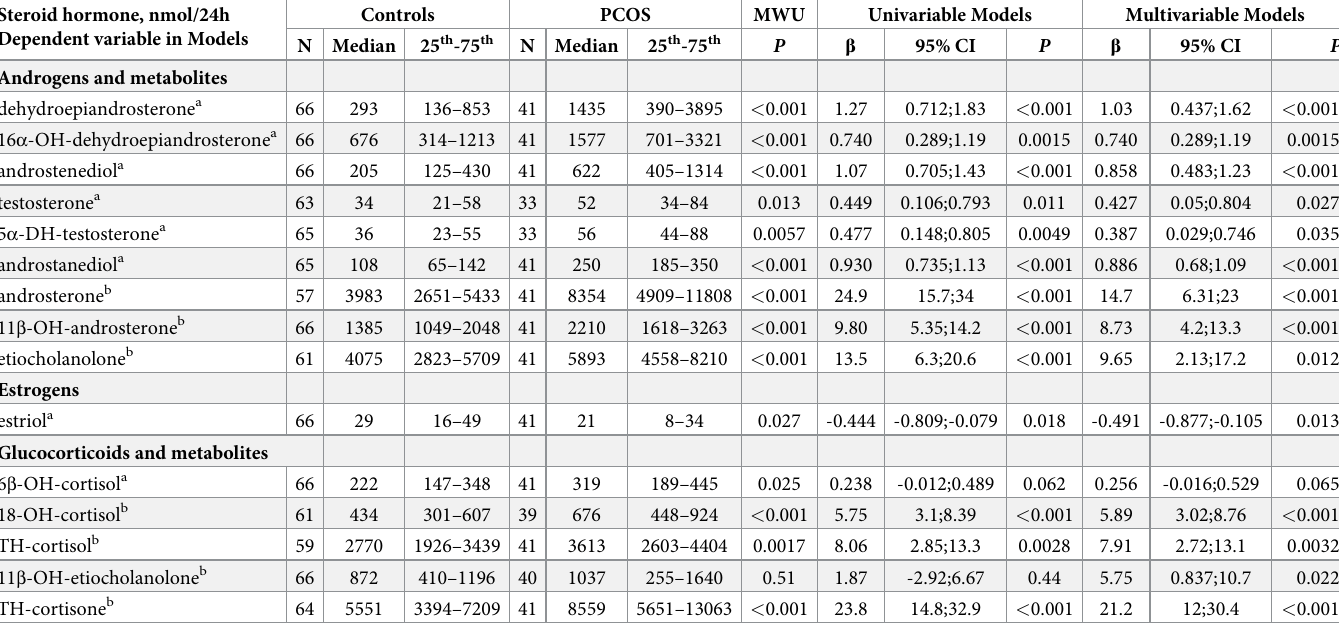
a Dependent variable natural log transformed in regression models. b Dependent variable square root transformed in regression